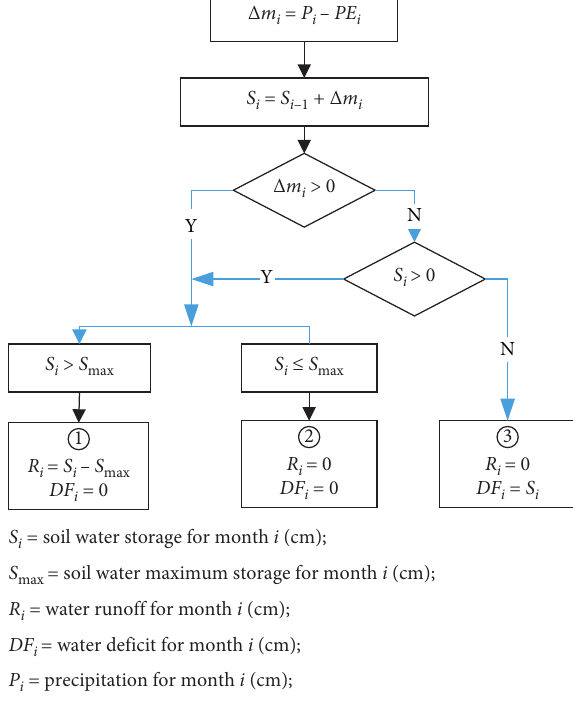
Figure 1: Moisture balance calculation